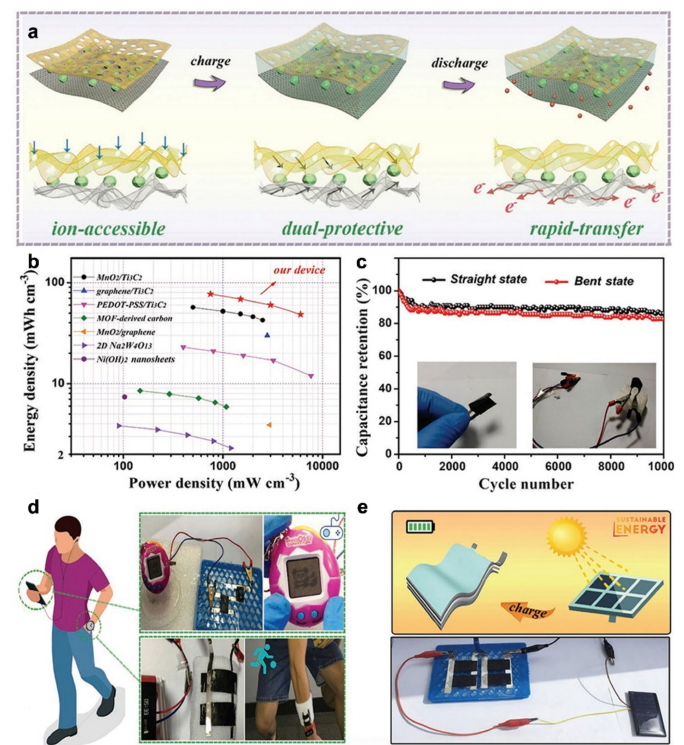
Figure 6. ( a ) Schematic illustration of the charge-discharge processes for FQDs/CNTC film electrode. ( b ) Ragone plot of the as-designed flexible SC. ( c ) Cycling performance of the flexible SC under the bent state. ( d ) Digital photos of the flexible SCs power diverse portable electronics. ( e ) Schematic of the flexible SC charged by harvesting solar energy [78].